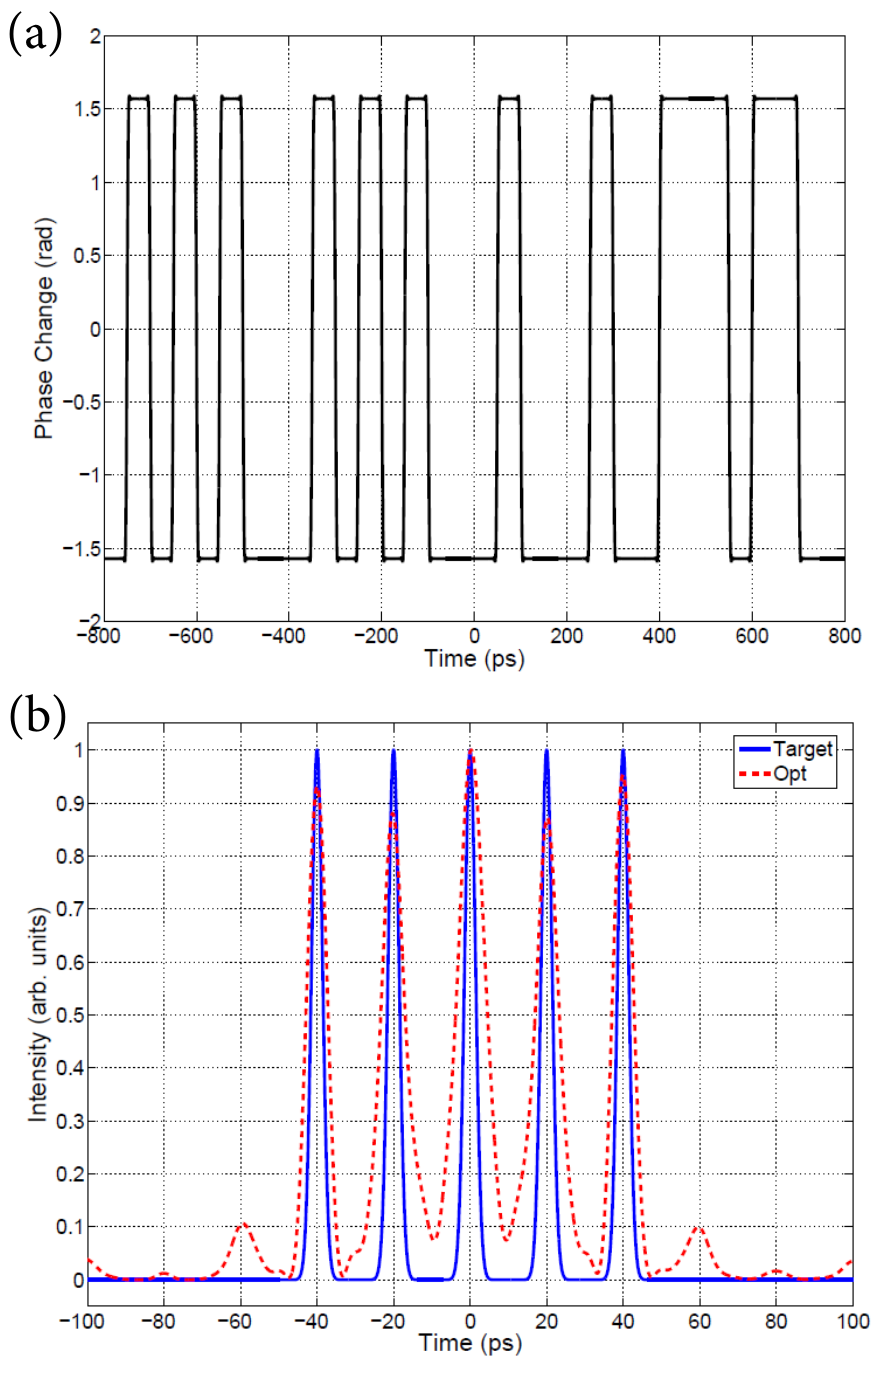
Figure 7. Simulated Annealing method. ( a ) Optimal phase modulation code. ( b ) Target and optimized temporal intensity